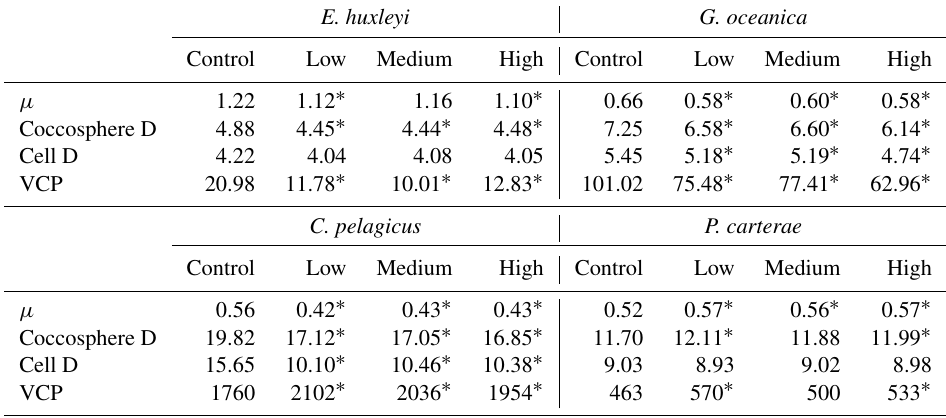
Table 2. µ is the growth rate, coccosphere D (µm) is the coccosphere diameter, cell D is the cell diameter (µm) and VCP is the volume of the calcitic portion (d − 1 ) of the coccosphere (µm 3 ) . Significance was tested using an ANOVA and a Tukey post-hoc test ( p <0.05). Asterisks indicate significant difference from the control treatment.